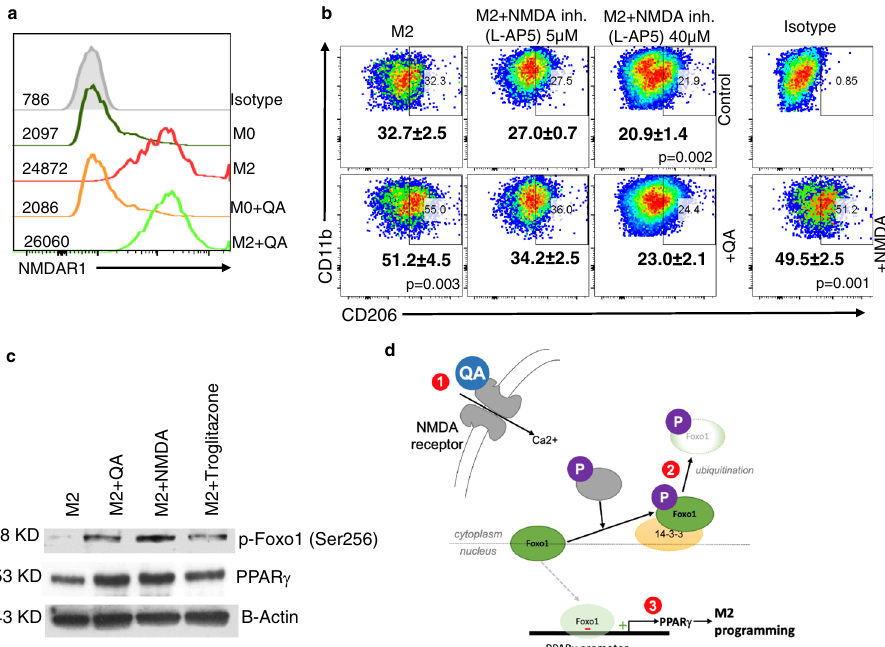
Fig. 6 | QA modulates M2 macrophage polarization through the NMDAR/ Foxo1/PPAR γ signaling axis. a M2 macrophages were polarized ±QA, gated for macrophage markers (CD45+CD11b+F4/80+) and CD206+ve with (green) or without (red) QA or CD206-ve with (orange) or without (dark green) QA, and evaluated for expression of the NMDA receptor 1 (NMDAR1; n =2 biologically independent samples/group). b M2 macrophages were cultured in ±QA, L-AP5 (NMDAR1 inhibitor), or NMDA and cells were gated for M2 macrophages markers (CD45+CD11b+F4/80+CD206+). Numbers represent mean±SD ( n =3 biologi- cally independent samples/group). c M2 macrophages were cultured in ±QA, NMDA, or Trog, and indicated proteins were evaluated by western blot, which is